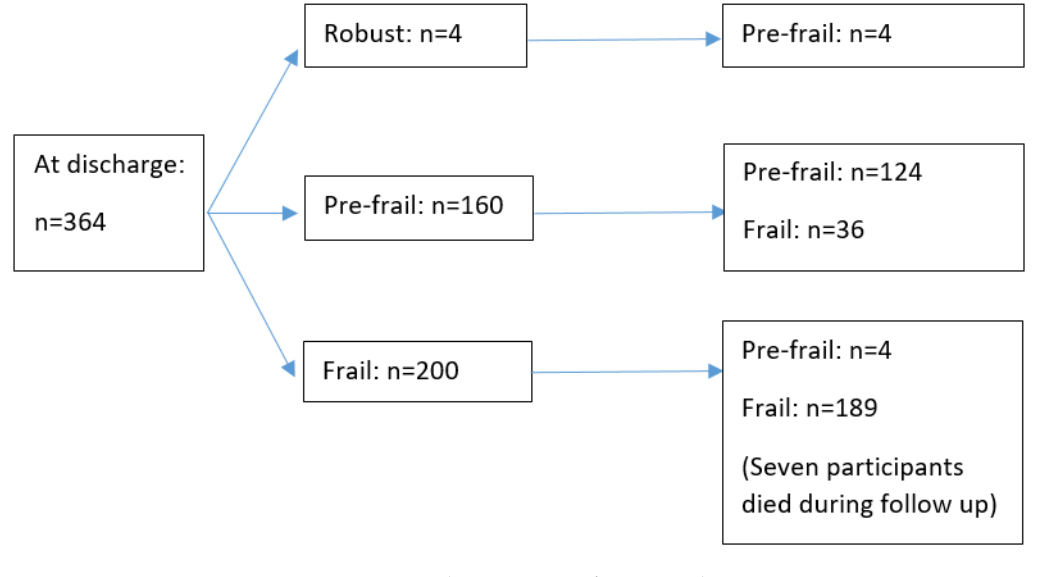
Figure 2. Frailty transition after 3 months. Table 2. Univariate logistic regression of potential associated factors for frailty transition among participants who were pre-frail before discharge ( n = 160).